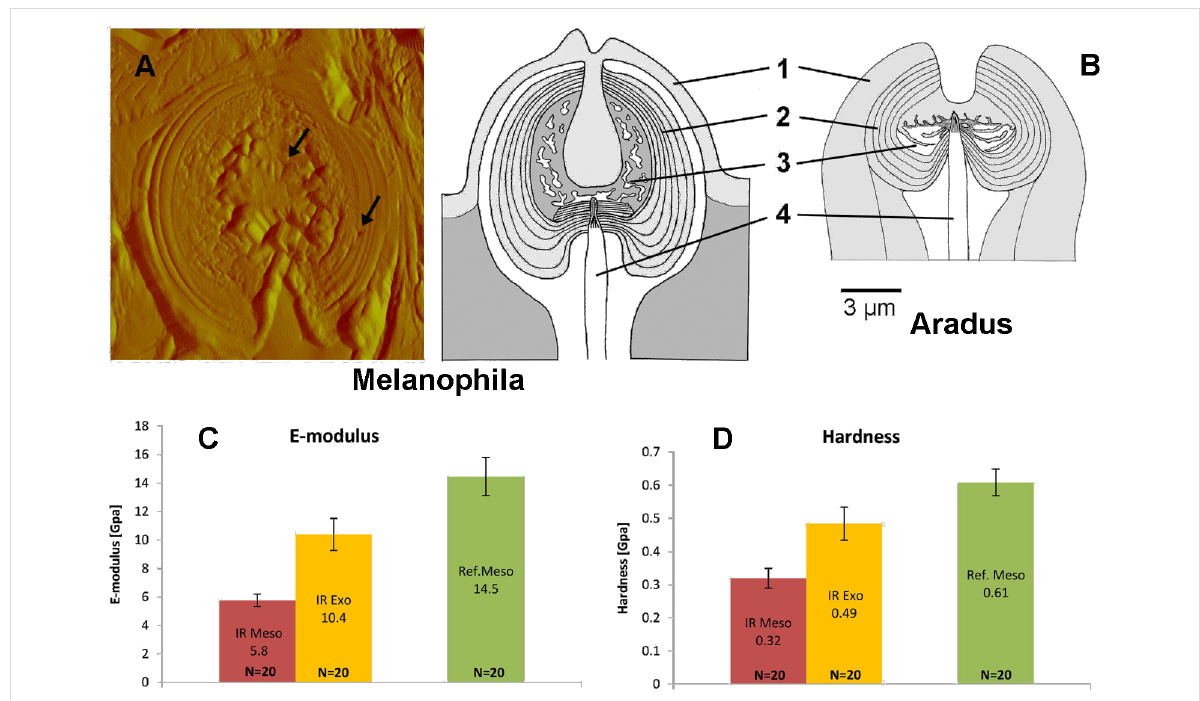
Figure 2: Schematic drawings of single IR receptors of Melanophila (A) and Aradus (B). 1: outer exocuticle; 2: exocuticular shell of the inner sphere; 3: microfluidic core; 4: tip of mechanosensory dendrite. For the Melanophila sensillum a topographical scan made with the tip of the nanoindenter is also shown on the left. Arrows point to indentations in the exocuticular shell of the sphere ("IR Exo" in C and D) and in the mesocuticle of the core ("IR Meso" in C and D). (C) and (D): E-modulus and hardness of different regions of the Melanophila sensillum measured by nanoindentation (for details see “ Experimental” section ). Twenty indents were made in each region. "Ref. Meso": reference mesocuticle outside of IR receptor.